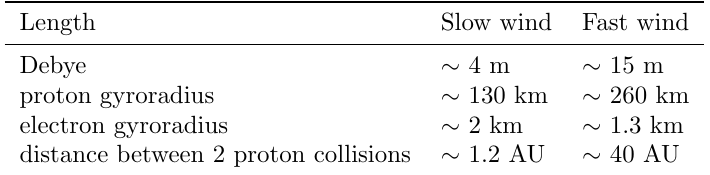
Table 9: Typical values of different lengths at 1 AU plus the distance traveled by a proton before colliding with another proton. These values have been obtained from the parameters reported in Table 6.